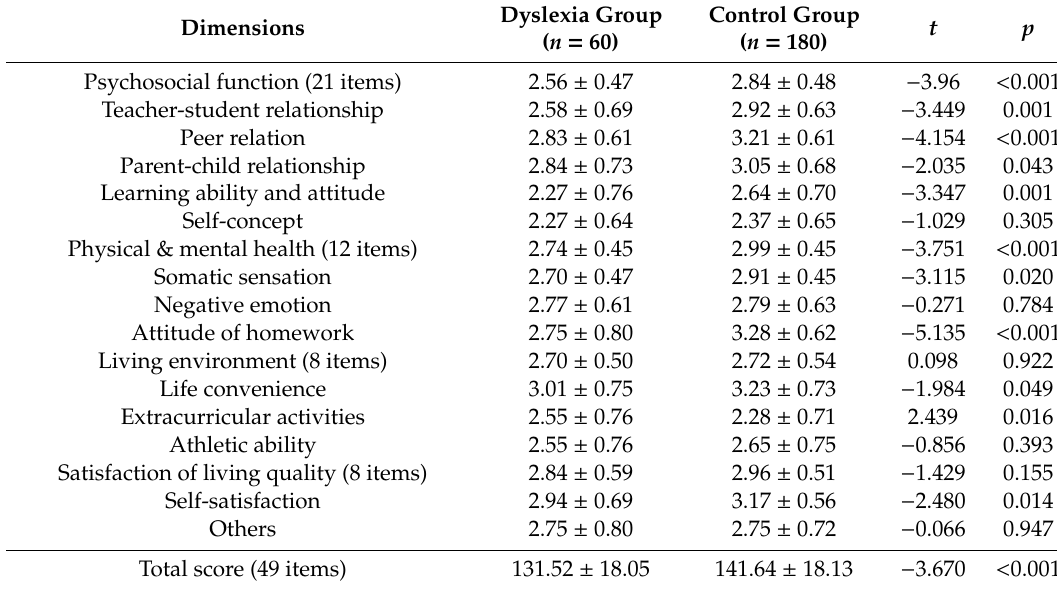
Table 4. Comparison of Quality of Life scale for children and adolescents (QLSCA) Scores between the dyslexia and control groups (Mean ±